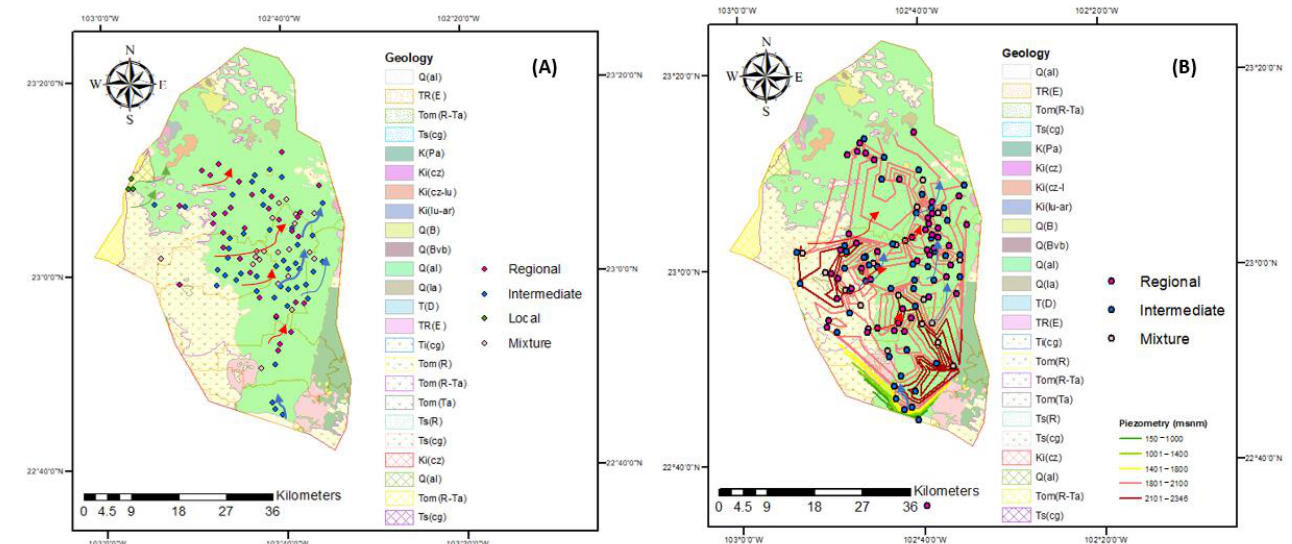
Figure 2. Corresponding wells in each flow system in the years ( A ) 2005 and ( B ) 2015.